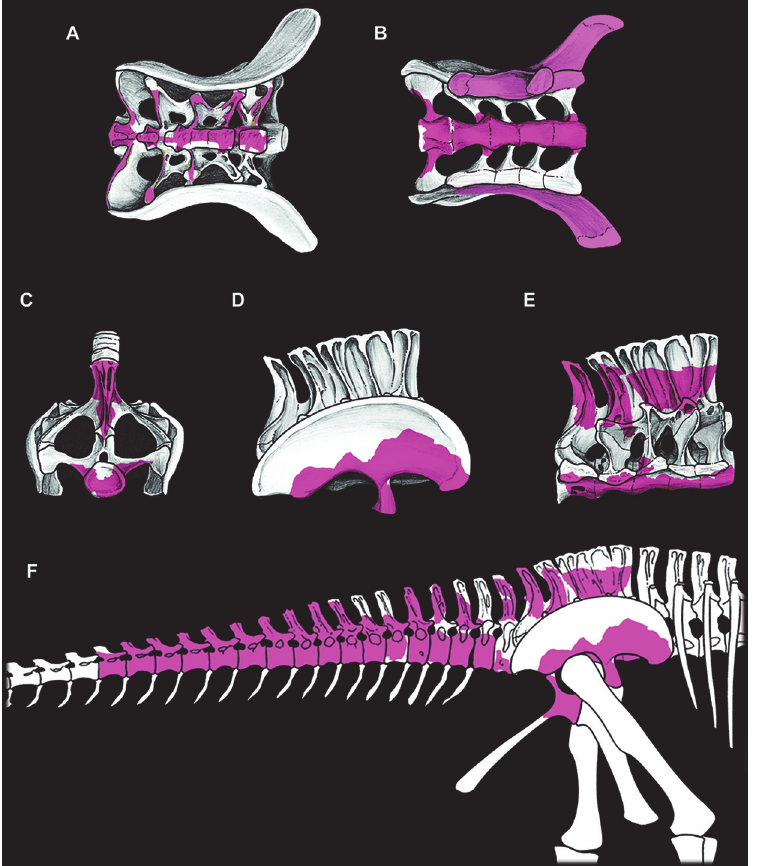
Fig 6. Sacrum with associated ilia, and reconstruction of known elements of Tataouinea hannibalis . Sacrum in dorsal view (A), ventral view (B), caudal view (C), right lateral view with ilium associated (D) and with ilium removed (E). In (B), the peduncles of the right ilium are removed. Skeletal reconstruction of caudosacral region of Tataouinea hannibalis (F). Recovered elements in colour. A full skeletal reconstruction is shown in S1